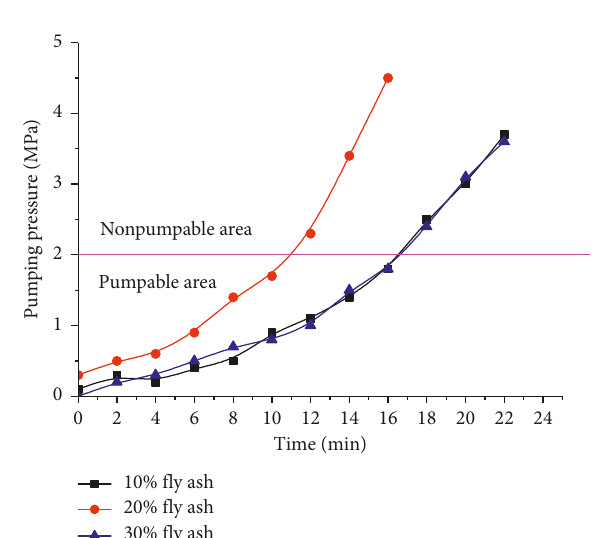
Figure 4: Pumping pressure changing with additive dosage